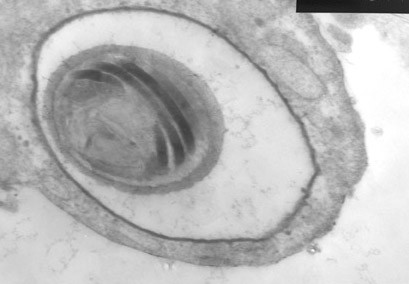
Inset shows an electron lucent thick capsule with a single nucleus and 11 – 13 tubules in the cytoplasm.